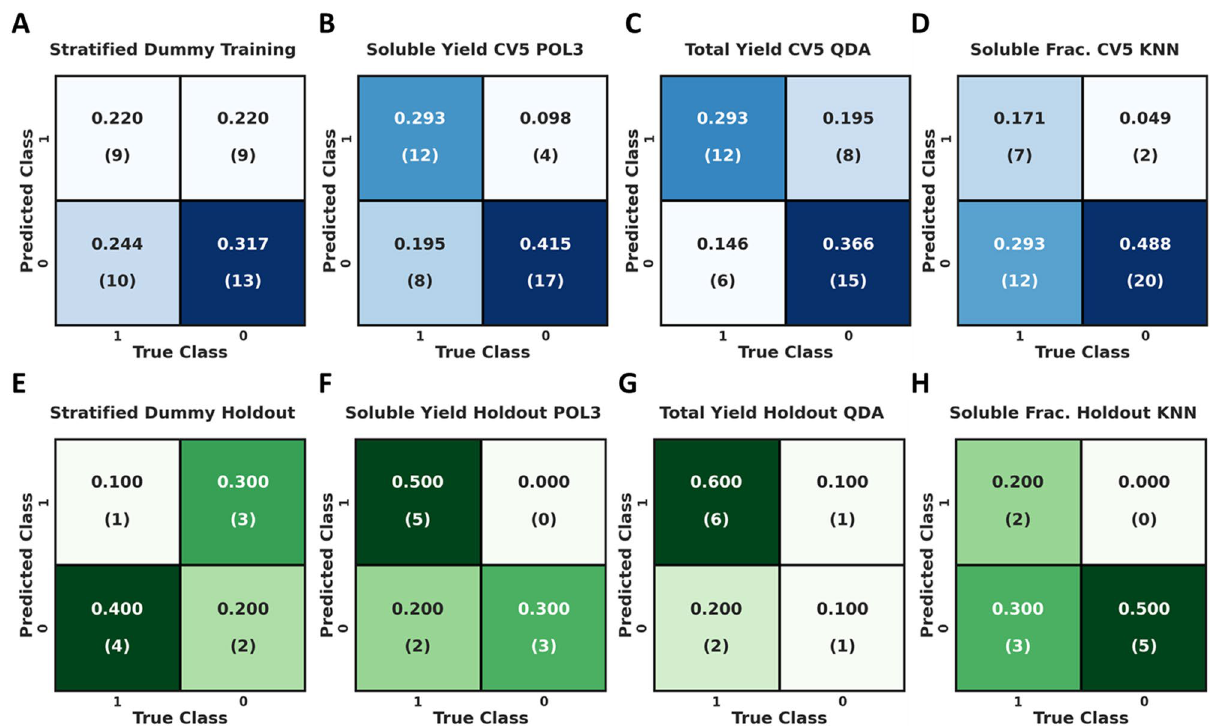
Figure 3. Confusion matrices showing predictions from stratified CV5 and prediction of the holdout. The top row ( A – D ), shows cross validation scores for ESFs and the bottom row ( E – H ), shows holdout prediction for ECSFs. Matrices A and E display the results of a dummy classifier using the stratified criterion, matrices B and F display the tuned soluble yield models, matrices C and G display the tuned total yield models, and matrices D and H display the tuned soluble fraction models. Note: POL3, QDA, and KNN are the Support Vector Degree 3, Quadratic Discriminant, Analysis, and K Nearest Neighbors classifiers respectively. Advanced metrics can be found in Table 5.